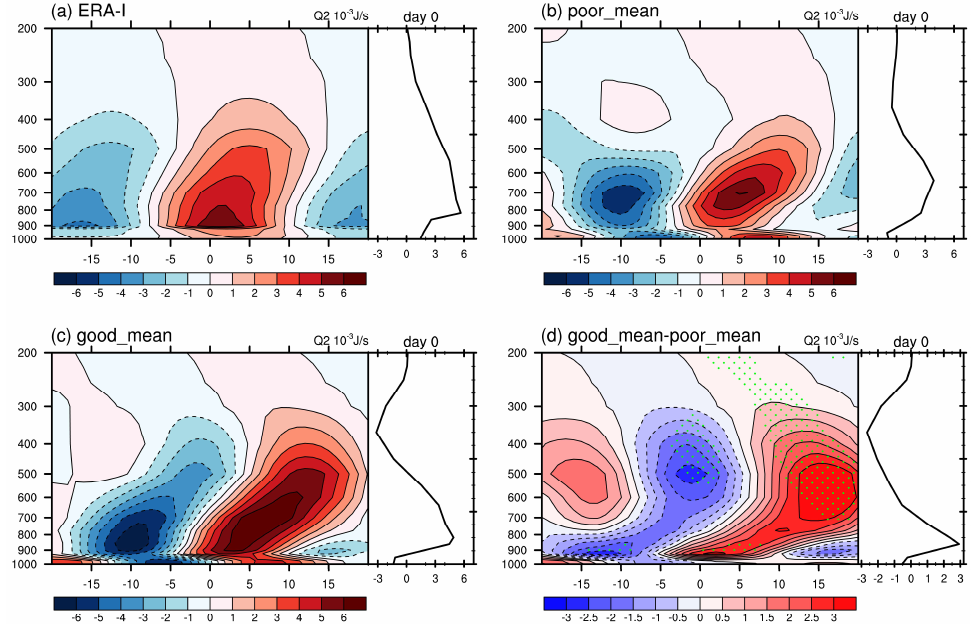
Figure 15. Time-height cross section (averaged over 10 ◦ S–10 ◦ N, 90 ◦ E–120 ◦ E) of lag regressed Q 2 from day −20 to 20 against the area-averaged 20–100 day filtered OLR time series at the reference area (5 ◦ S–5 ◦ N; 75 ◦ –85 ◦ E), along with the regressed Q 2 profile at day 0 in ( a ) observation, ( b ) composite of poor simulations, ( c ) composite of good simulations and ( d ) di ff erence between composites of good and poor simulations where the di ff erences reaching 90% confidence level are dotted.